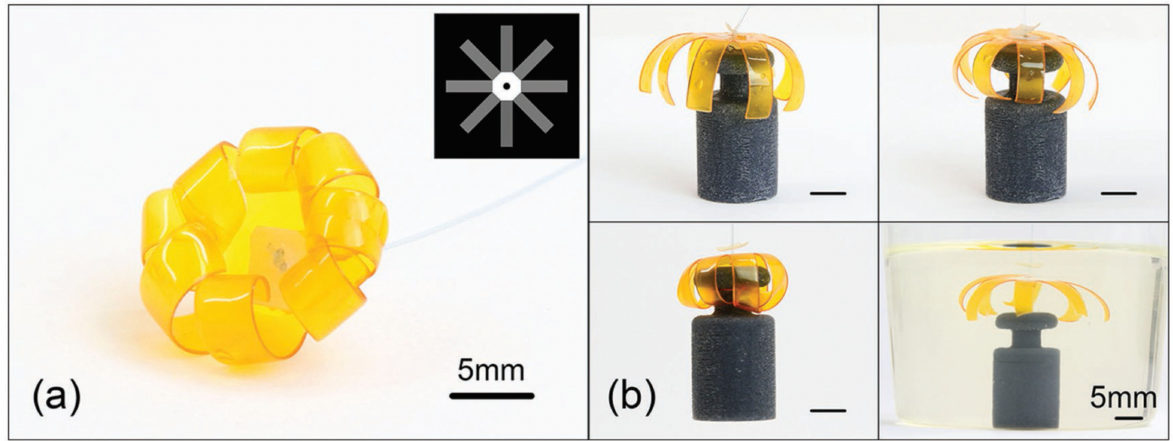
Figure 20. ( a ) Self-folding, flower-shaped gripper. ( b ) Grip- and release-process snapshots. The gripper was first swollen and opened in acetone (in around 10 s). The petals progressively folded with the volatilization of acetone after the opening gripper was placed on top of a weight (2.5 g) (within 2 min). Copyright 2016 John Wiley@Sons. Reprinted with permission from ref.